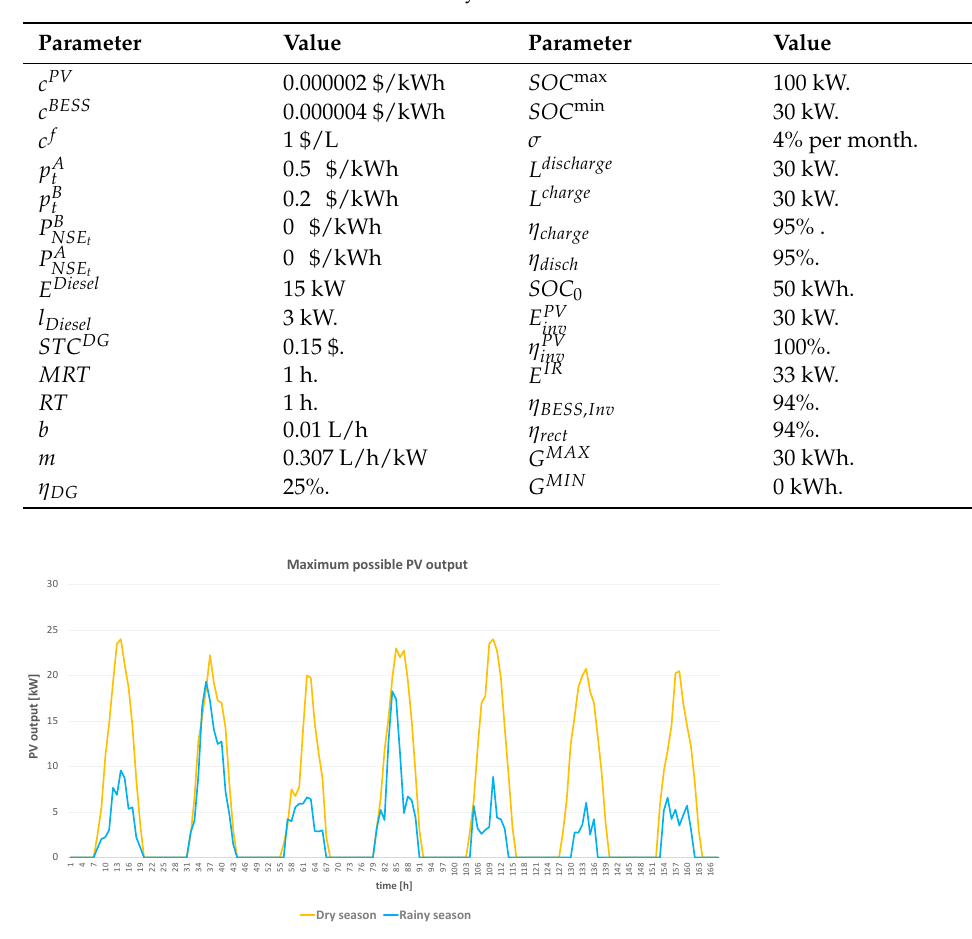
Table A1. Parameter values for the case study.